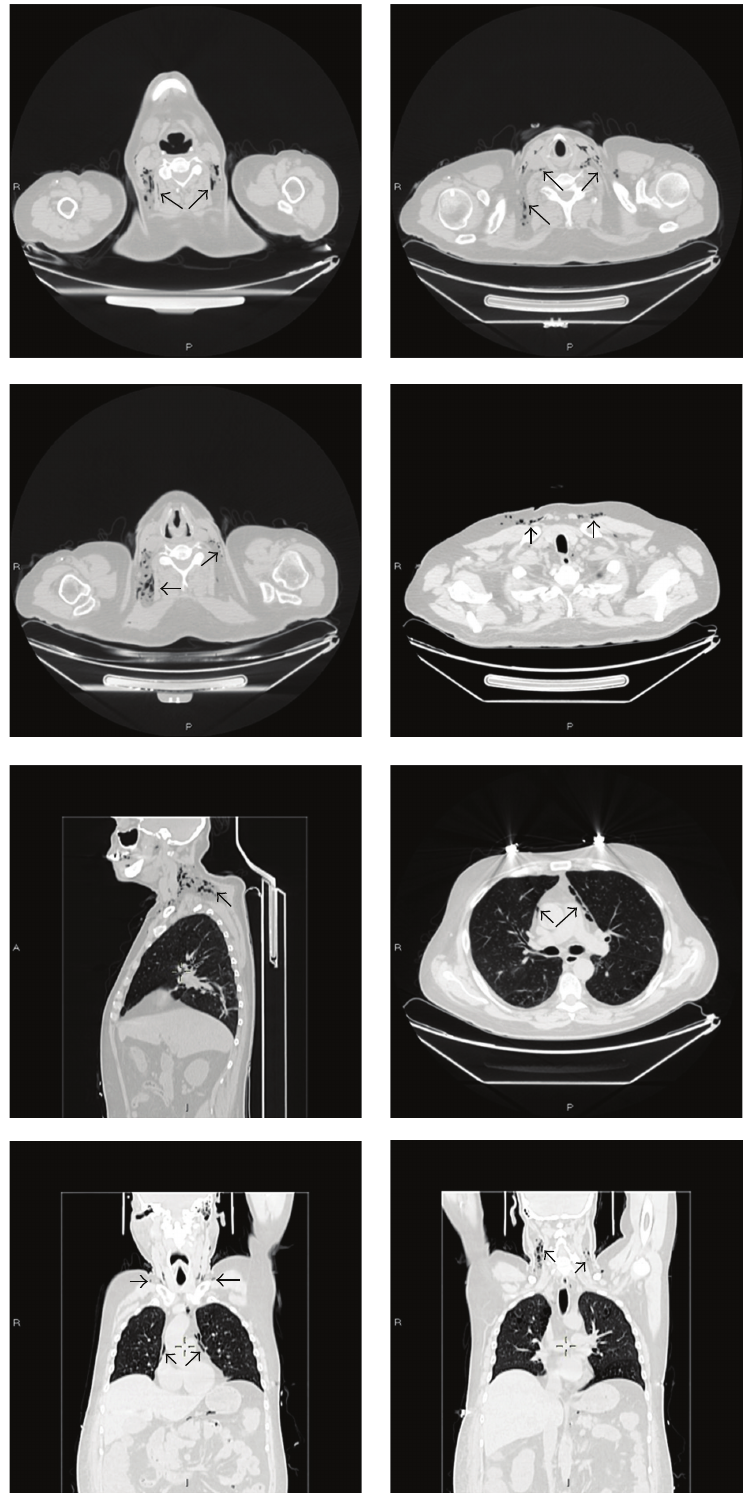
Figure 3: Whole body CT scan revealed free gas in the mediastinum and subcutaneous tissue, dissecting soft tissues and muscles from the maxillary to the sternocleidomastoid muscle and the sternoclavicular joint bilaterally. Free gas was also evident in correspondence of the dorsal and pectoral soft tissues (black